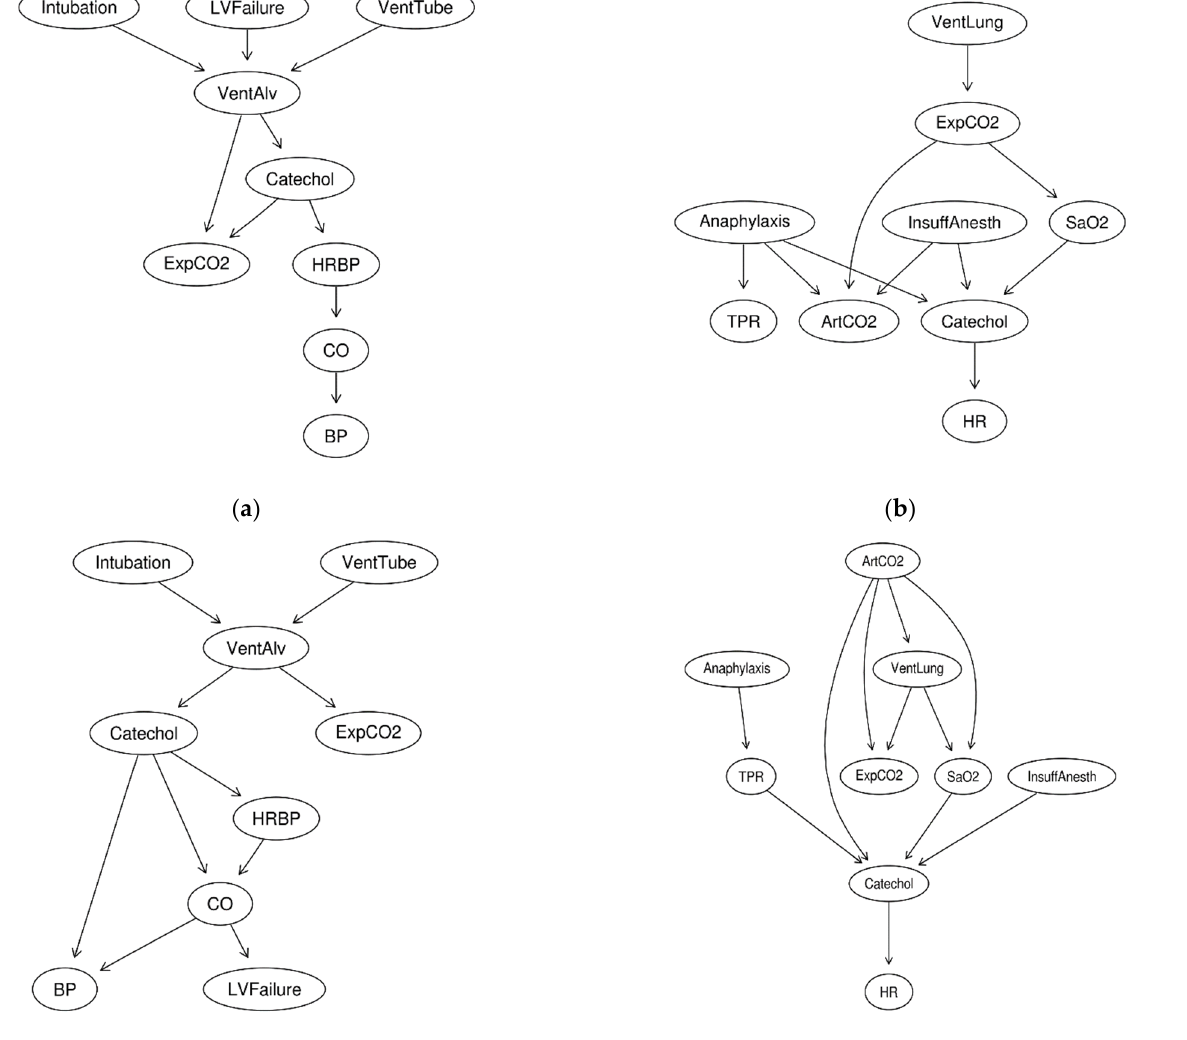
Figure 6. The highest scored Global BDe Structure for ( a ) D50S9 (14.23%), ( b ) D50C9 (15.71%), ( c ) D1KS9 (>99%) and ( d ) D1KC9 (4.03%). BDe percentage score in the parentheses.